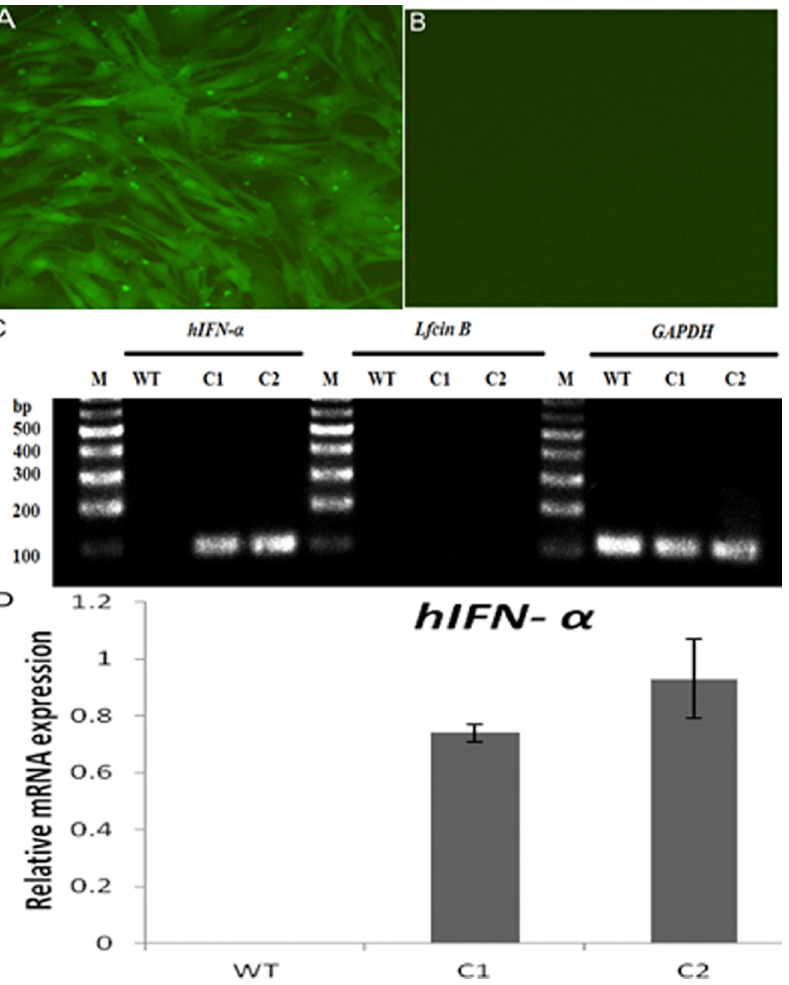
Figure 1. hIFN- a and LFCINB gene expression in transfected bovine fetal fibroblasts. GFP was expressed in transfected bovine fetal fibroblasts ( 6 200) (A), but not in wild-type bovine fetal fibroblasts ( 6 200) (B). Green: green fluorescent protein (GFP). (C, D) hIFN- a and LFCIN B gene expression in transfected bovine fetal fibroblasts was analyzed using real-time RT-PCR, with results normalized to expression levels of GAPDH . WT, Wild-type bovine fetal fibroblasts; C1, transfected bovine fetal fibroblast clone 1; C2, transfected bovine fetal fibroblast clone 2. Relative mRNA expression levels are shown as means 6 standard deviation (SD) from three independent experiments.